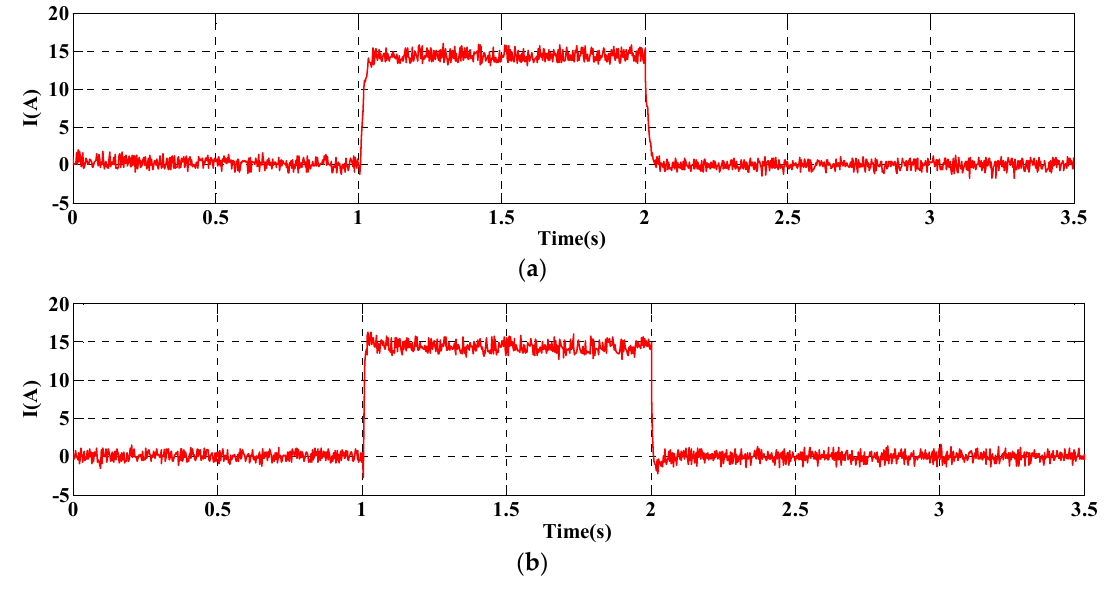
Figure 13. Current i q of PMIWM. ( a ) FTSMC, ( b ) SMC.